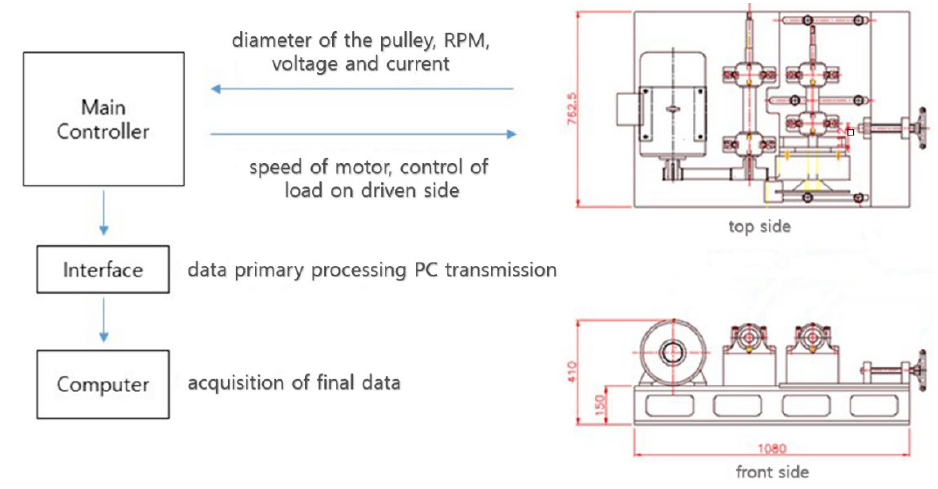
Figure 15. CVT tester.